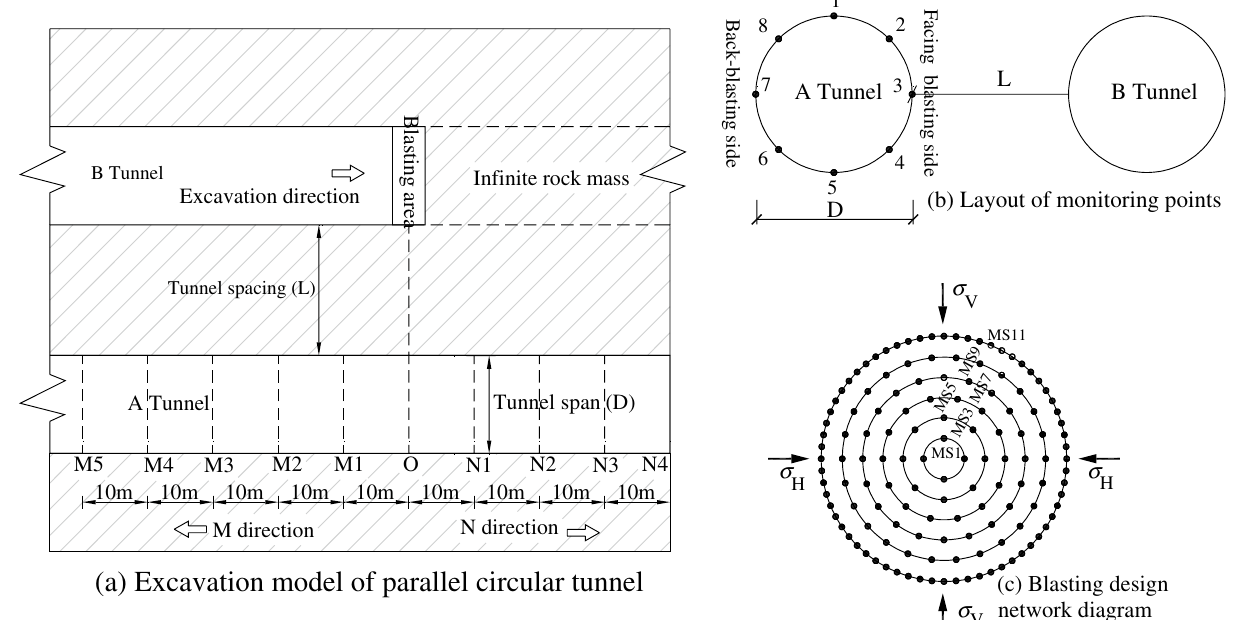
Figure 4. Blasting excavation model and scheme of parallel circular